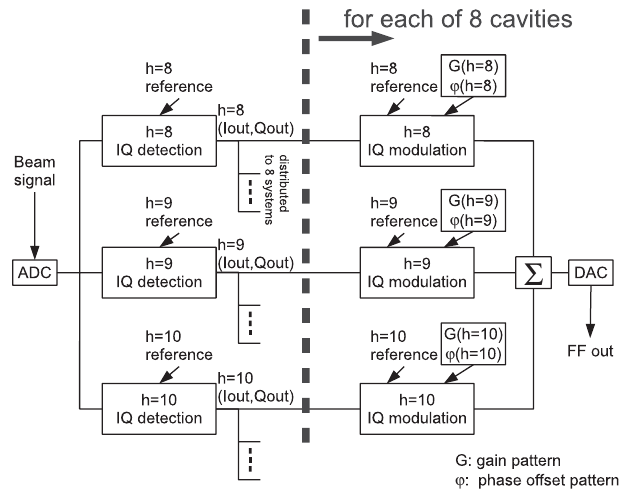
FIG. 6. Block diagram of the multiharmonic rf feedforward system for the